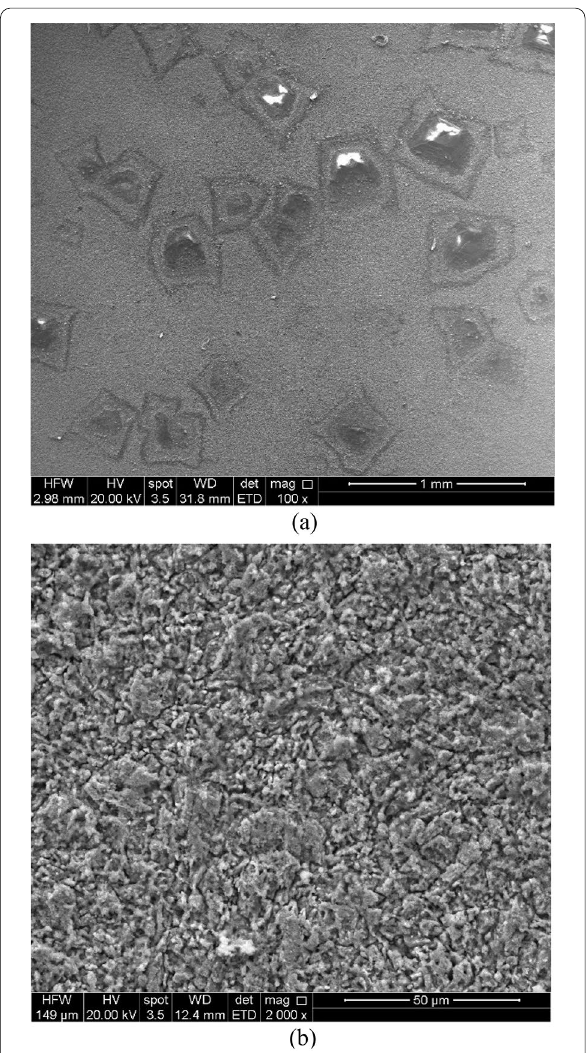
Figure 13 Corroded morphologies of the CuMn 13 Al 7 sample formed by wire arc additive manufacturing in 3.5 wt% NaCl